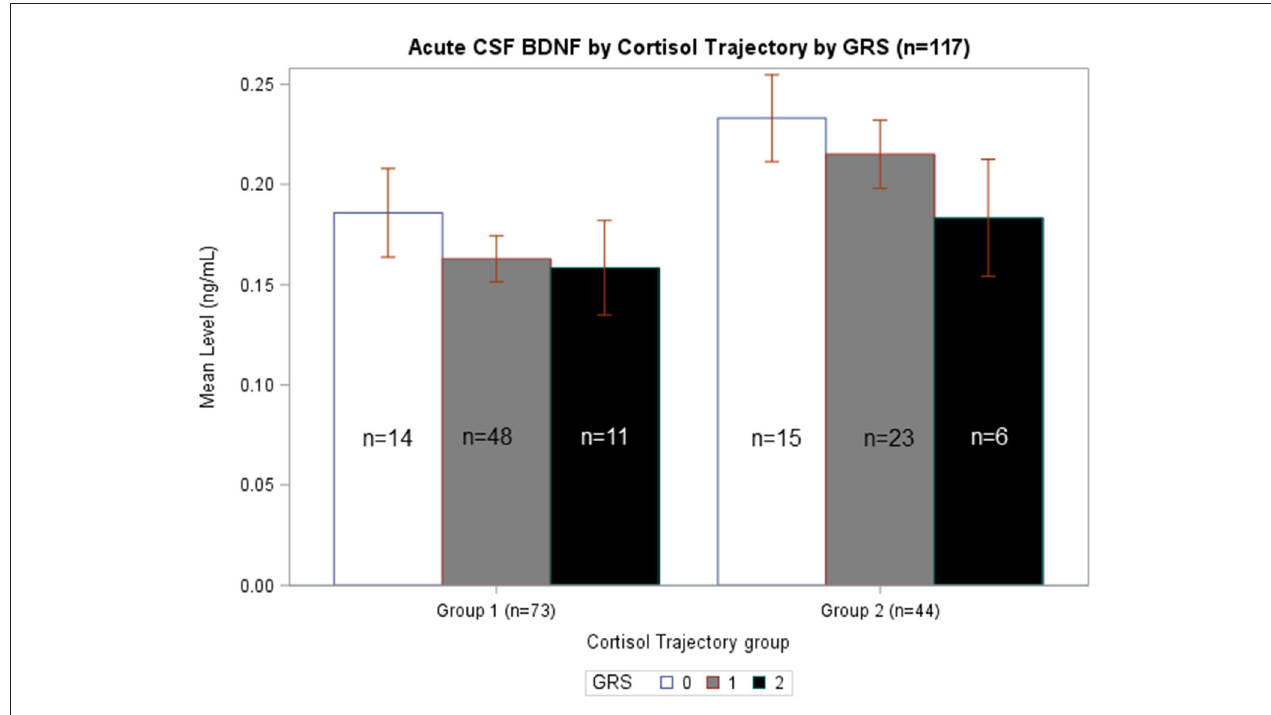
FIGURE 4 | Acute CSF BDNF by Cortisol Trajectory Group by GRS. Weekly average CSF BDNF (ng/mL) is reported. Error bars indicate standard error of the mean. White, gray, and black corresponds to GRS scores of 0, 1, and 2, respectively. Results are stratified among the high ( n = 44) and low ( n = 73) cortisol TRAJ groups. Among individuals with GRS = 1, those in the high cortisol TRAJ group had significantly elevated BDNF levels compared to those in the low cortisol TRAJ group p = 0.011. There were no significant differences in BDNF levels by cortisol TRAJ group for individuals with GRS of 0 or 2.